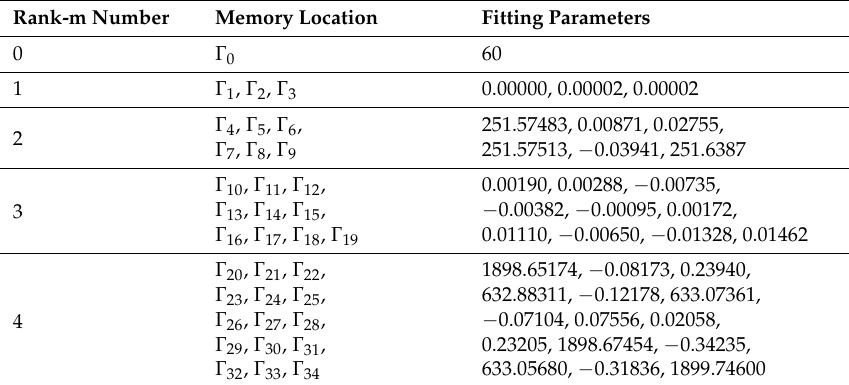
Figure 3. Discrete summation for the calculation of the intermolecular interaction potential between two approaching fullerenes. ( a ) All-atom model: 3600 times per step, and ( b ) coarse-grained model: one time per step. Table 3. Fitting parameters for the interaction moment